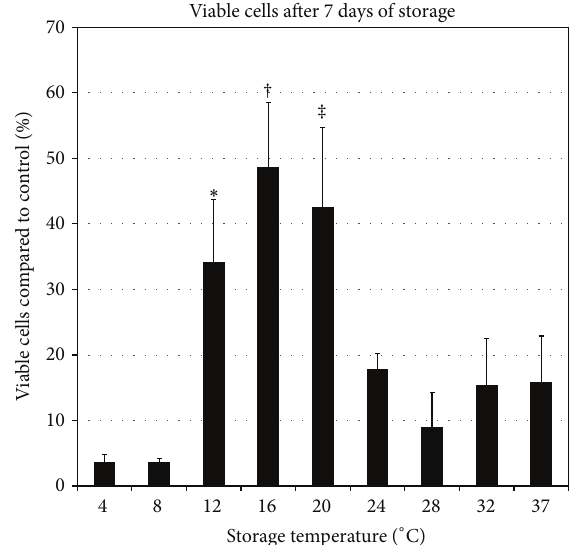
Figure 4: Cultured RPE cells were stored for seven days at 4 ∘ C, 8 ∘ C, 12 ∘ C, 16 ∘ C, 20 ∘ C, 24 ∘ C, 28 ∘ C, 32 ∘ C, and 37 ∘ C, and viability was assessed with a calcein-acetoxymethyl ester reagent. The bar chart showsthepercentageofviablecellsafterstoragecomparedtocontrol cells (100%). ∗ 𝑃 < 0.01 compared to 4 ∘ C, 8 ∘ C, 28 ∘ C, and 37 ∘ C; 𝑃 < 0.05 compared to 24 ∘ C and 32 ∘ C. † 𝑃 < 0.01 compared to 4 ∘ C, 8 ∘ C, and 24 ∘ C–37 ∘ C; 𝑃 < 0.05 compared to 12 ∘ C. ‡ 𝑃 < 0.01 compared to 4 ∘ C, 8 ∘ C, and 24 ∘ C–37 ∘ C. Error bars represent the standard deviation of mean